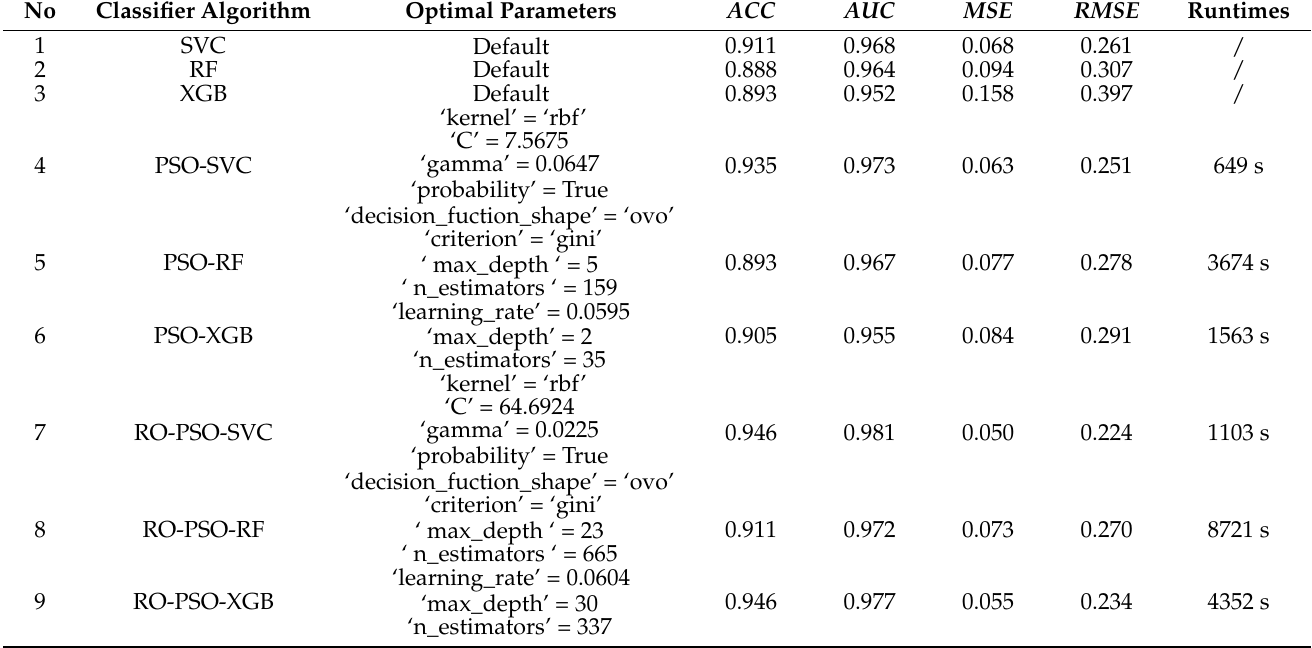
Table 3. Final optimal super parameters of the models and consumed time (Note: for an explanation of each parameter and its role in the model adjustment, refer to the Scikit-learn website: https: //scikit-learn.org, accessed on 20 February